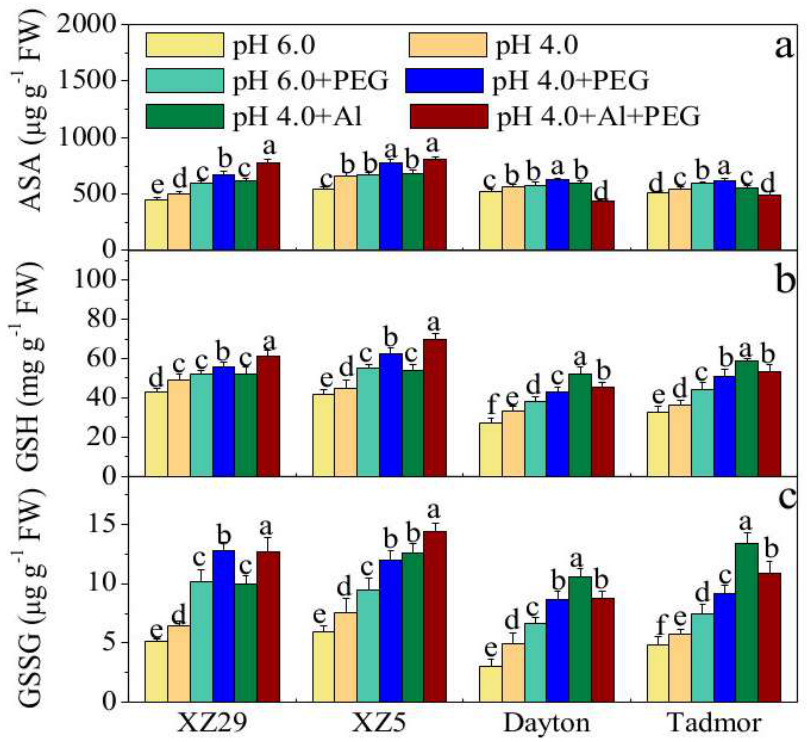
Figure 4. Effects of pH, PEG, Al, and pH 4.0+Al+PEG stresses on the levels of non-enzymatic antioxidants ( a ) reduced ascorbate (ASA), ( b ) reduced glutathione (GSH), and ( c ) oxidized glutathione (GSSG) of four barley genotypes seven days after treatment. Error bars represent SD values ( n = 6). Different letters indicate significant differences among the treatments within each genotype according to Duncan’s multiple range test with p < 0.05.